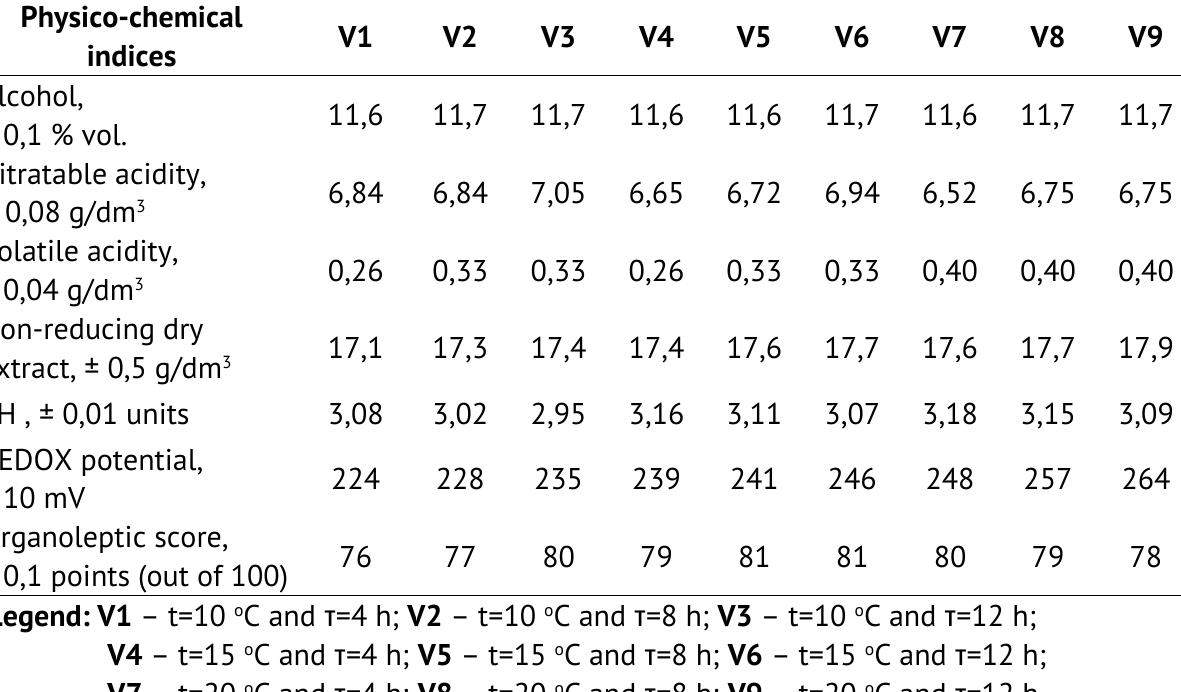
Physico-chemical indices of Viorica variety dry white wines depending on the duration and temperature of